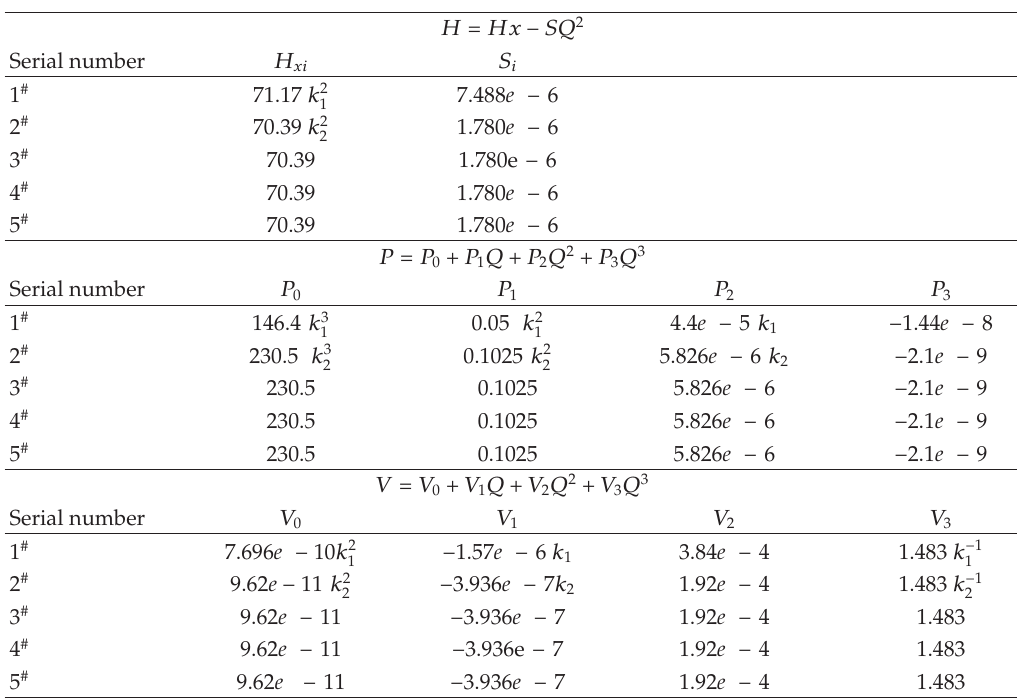
Table 2: The model parameters of the